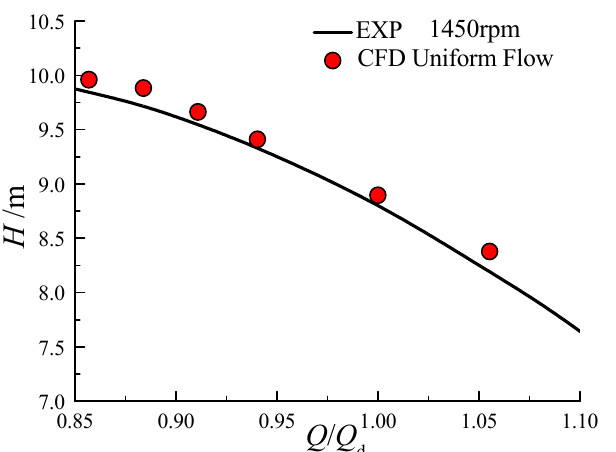
Figure 5. Head comparison between experimental and numerical results, at 1450 r/min.